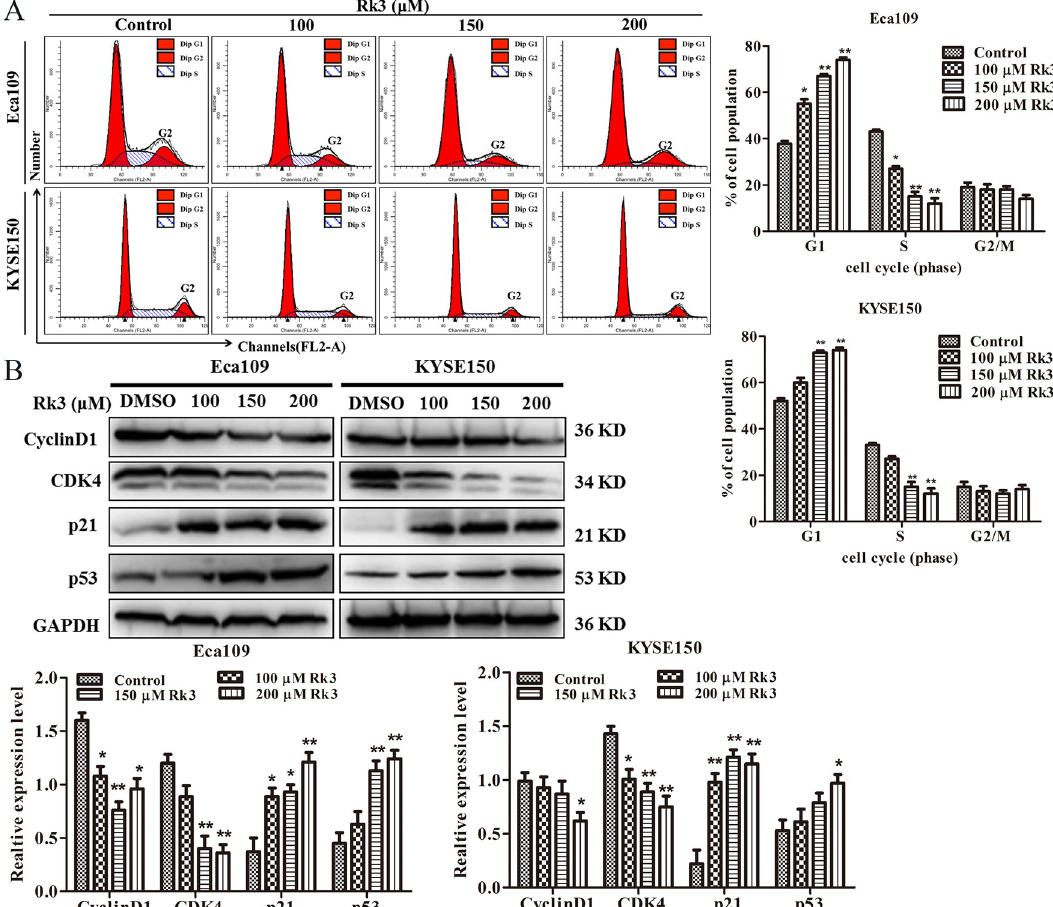
Fig 2. Rk3 triggers G1 arrest in Eca109 and KYSE150 cells. (A) Cell cycle distribution analyzed by flow cytometry. (B) The expression level of G1 transition-related proteins was evaluated by western blotting. � p < 0.05, �� p < 0.01 compared with